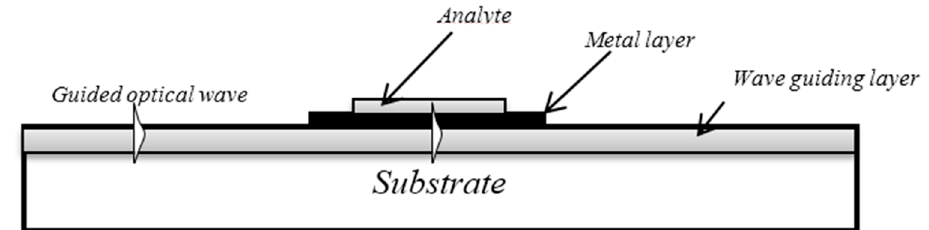
Figure 1. Optical waveguide-based SPR system.